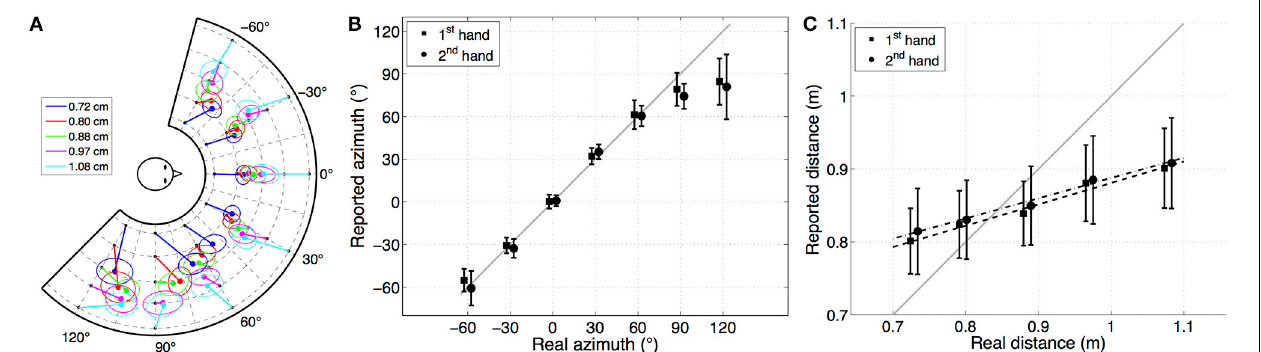
FIGURE 2 | (A) (Color on-line) Mean of all subjects’ reported location with 50% confidence ellipse linked to source location for the dominant hand condition. Front/back confusion corrected. Good directional pointing accuracy in the median plane, larger compression of reported distances in front than in side. (B) Mean of all subjects’ reported azimuth as a function of the target azimuth for both hand conditions. Error bars show one standard deviation across the subjects. Gray line shows unity. For the sake of readability, results